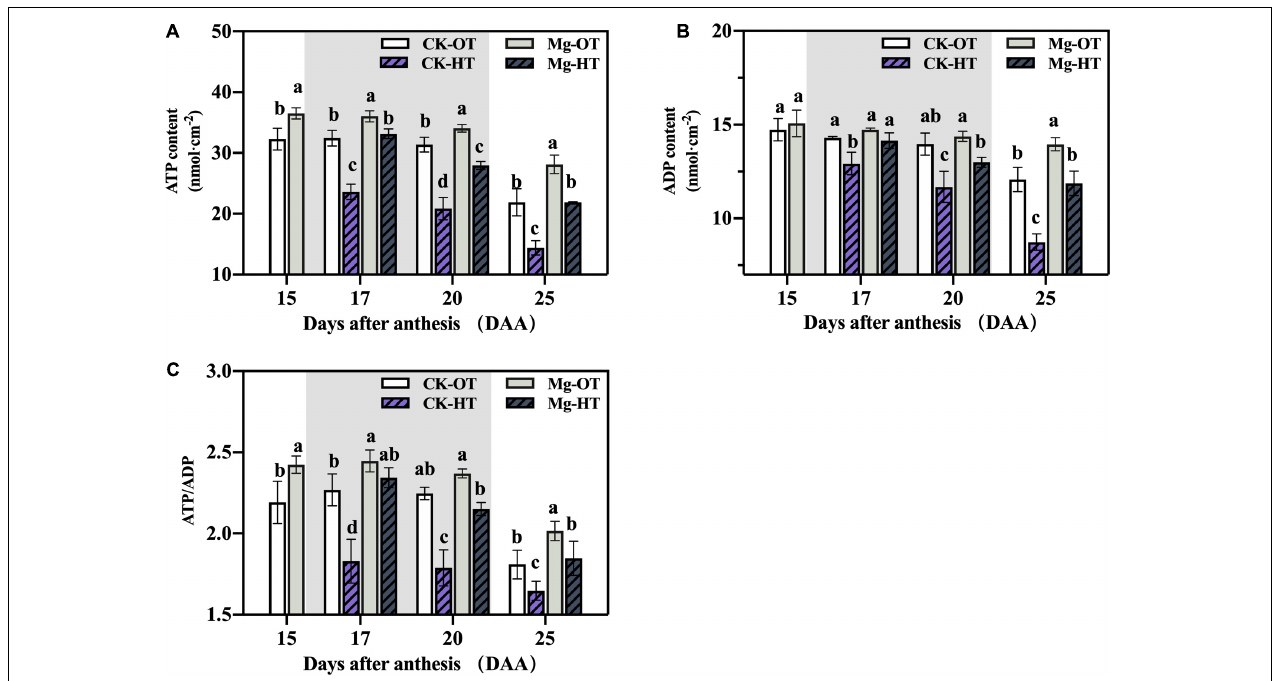
FIGURE 5 | Effects of Mg application on ATP content, ADP content, and ATP/ADP in flag leaves of wheat under HTS during grain filling. Two-way analysis of variance was performed; each bar is the mean ± SE of five replications. Different lowercase letters indicate significant variations within the same day at P < 0.5 (Duncan’s multiple-comparison tests). (A) ATP content, (B) ADP content, (C)